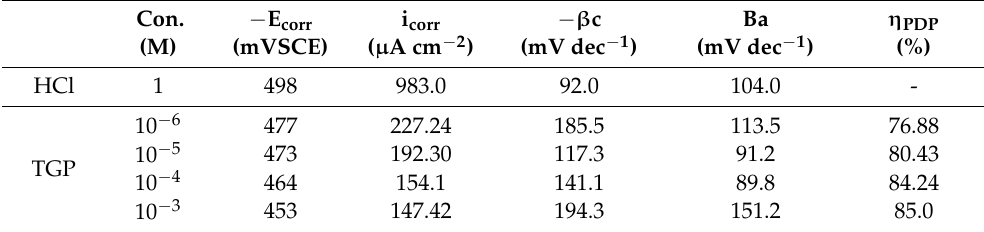
Figure 3. PDP curves for MS in 1 M HCl medium, both unprotected and protected, by varying concentrations of studied epoxy resin. Table 1. PDP parameters for MS in 1 M HCl solution, both unprotected and protected, by varying concentrations of TGP.